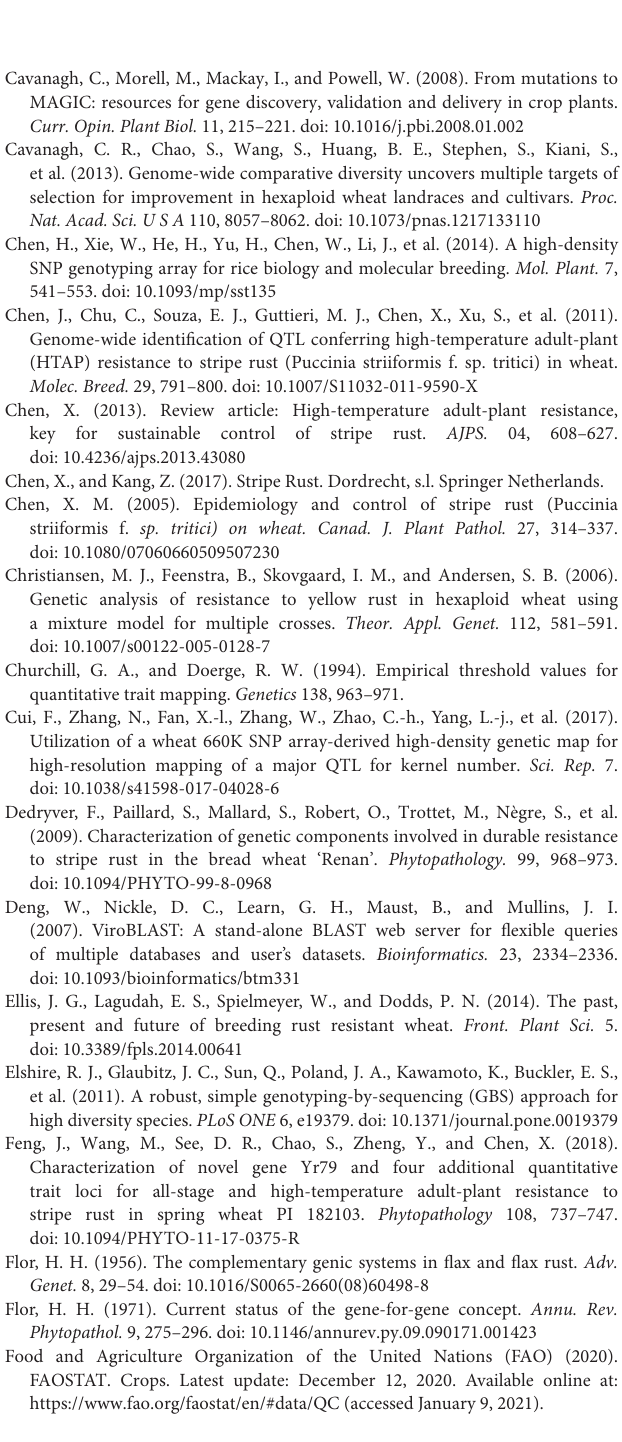
Supplementary Table 3 | Comparison of the physical positions of the QTL identified in the present study (bold) with those reported previously. Supplementary Table 4 | List of gene annotations for peak markers ± 500,000 bp, shown as output retrieved from URGI database